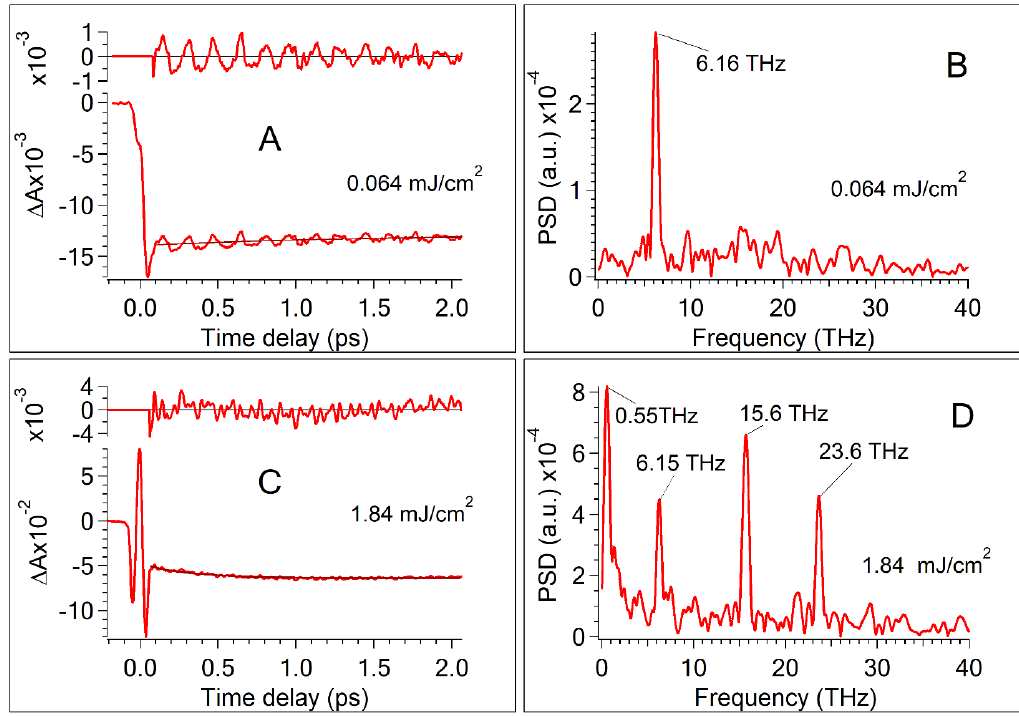
Figure 2. Transient kinetics of CdSe quantum dots (QDs) in toluene at a low and high level of pump fluence. The probe wavelength is 567 nm. Oscillation components were revealed as residuals of model function subtraction from the transient traces. Pump fluence: ( A ) 0.064 mJ/cm 2 ; ( C ) 1.84 mJ/cm 2 . Power spectral density (PSD) calculated by Fast Fourier Transform (FFT) of oscillation components. Pump fluence: ( B ) 0.064 mJ/cm 2 ; ( D ) 1.84 mJ/cm 2 .